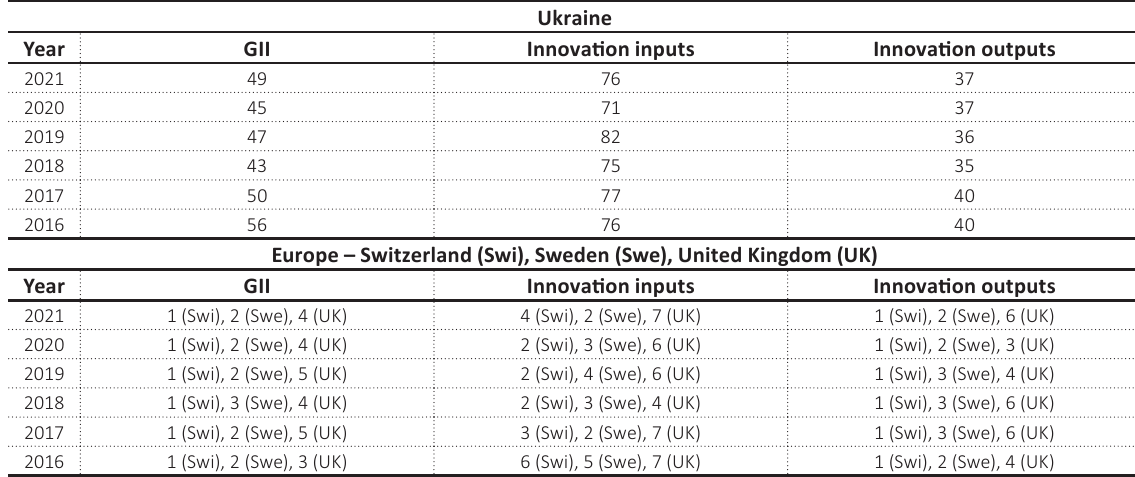
Source: WIPO (2021,